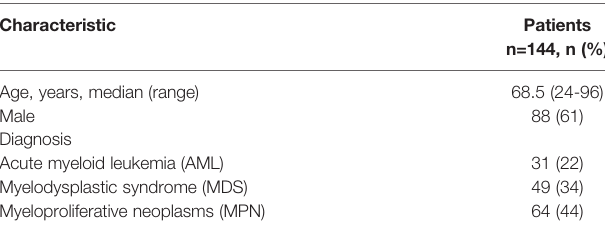
TABLE 1 | Patient